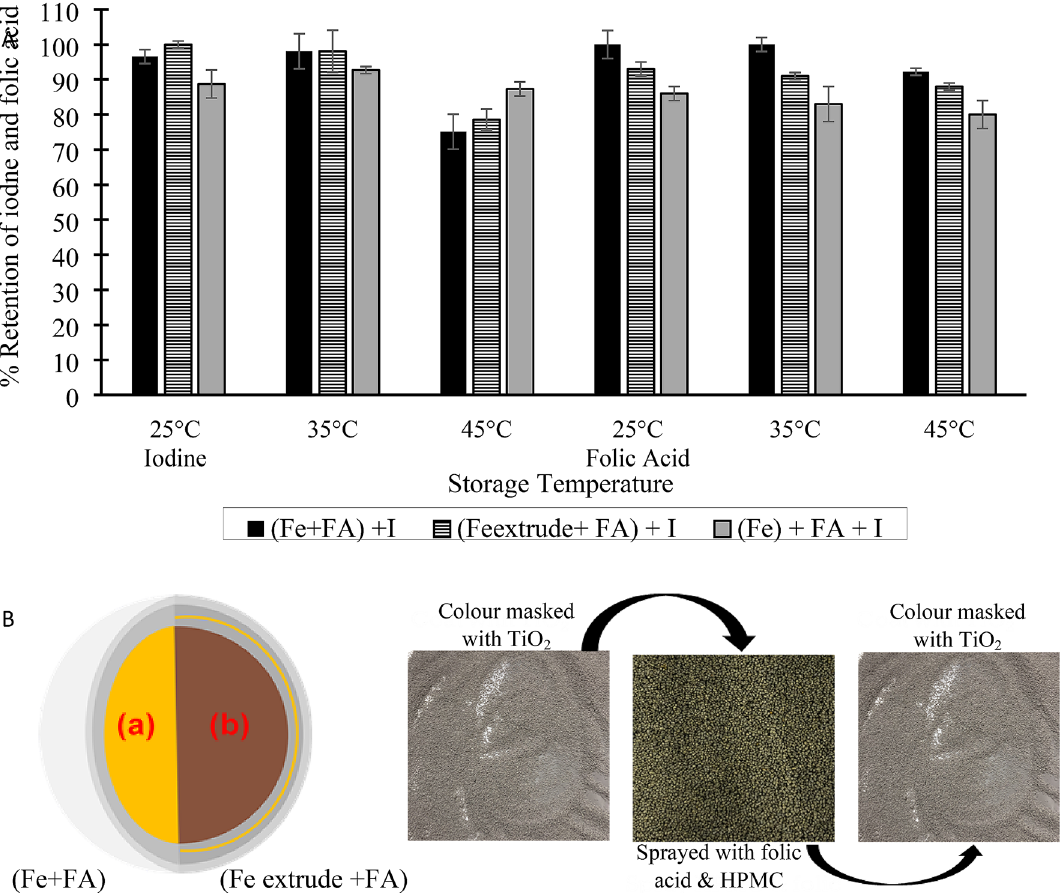
Figure 2. ( A ) Stability of iodine and folic acid in TFS formulated with Fe-FA premix. ( B ) Schematic of the two designs for iron-folic acid premix and how one of the premix samples (Fe extrude + FA) was made (Fe + FA) has both iron and folic acid in the core of the premix; (Fe extrude + FA) has folic acid separated by a tiny layer of TiO 2 in the premix; (Fe) has only iron in the premix, and folic acid and iodine was added as a